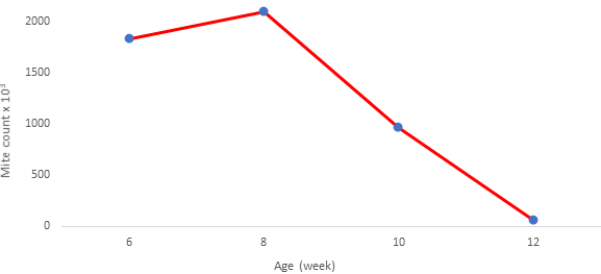
Figure 1. Mite population by weeks.